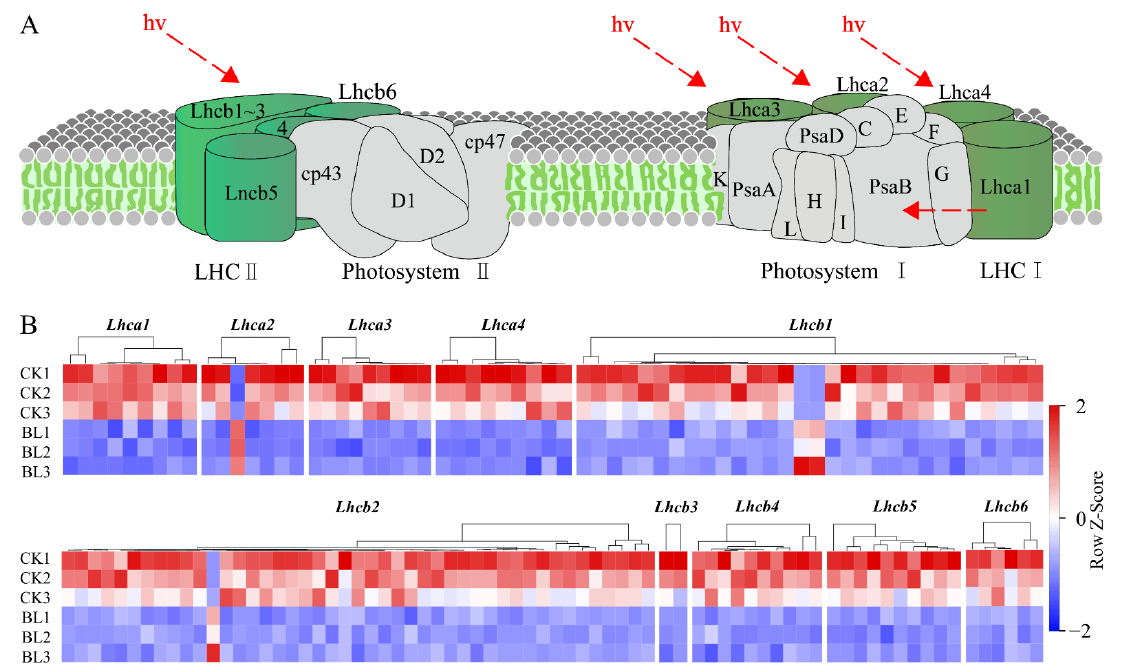
Figure 5. Almost all of the DEGs in the photosynthesis-antenna proteins pathway were downregulated in the BL treatment. ( A ) Photosynthesis-antenna proteins pathway (https://www.kegg.jp/pathway/map00196 (accessed on 24 April 2022)). ( B ) Expression heat maps of the DEGs in 10 subunits (Lhca1–Lhca4 and Lhcb1–Lhcb6 (accessed on 24 April 2022)) in the six samples, respectively.